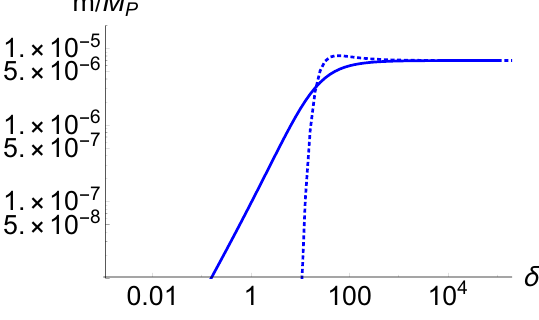
Figure 3. Inflaton mass m vs. δ with N e = 50 e -folds for the CW potential (2.10). Blue dotted line represents inflation in region 2) and blue continuous in region 3).